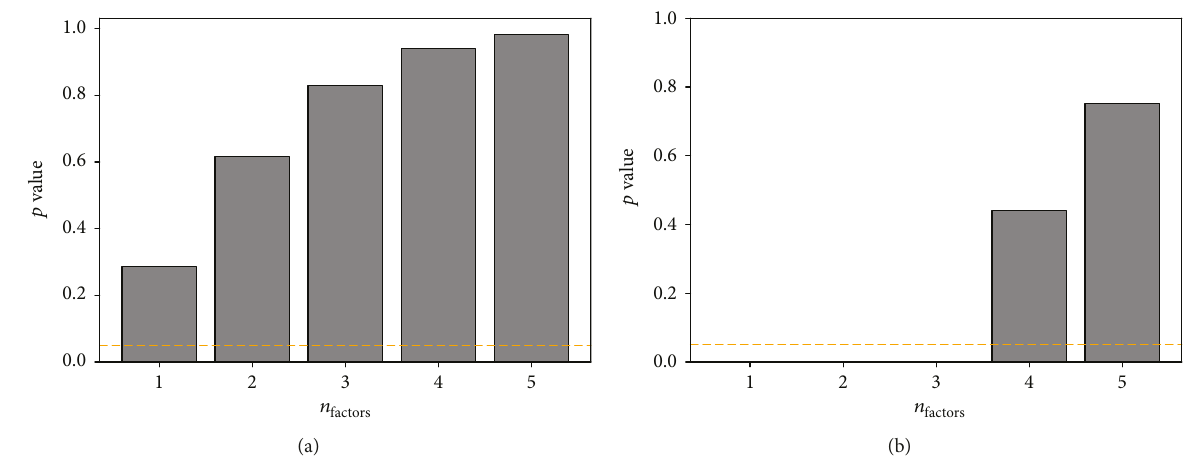
Figure 11: P -values obtained for a factorial model with a number of factors ranging 1 to 5, for 2 network topologies: Erdös-Rényi of size N = 50 and p = 0 4 (a) and Newman modular of size N = 256 , k total = 16 , and k in = 15 (b) networks, with parameters as in Figure 9. p value=0.05 is labelled in orange, as threshold for not rejecting the